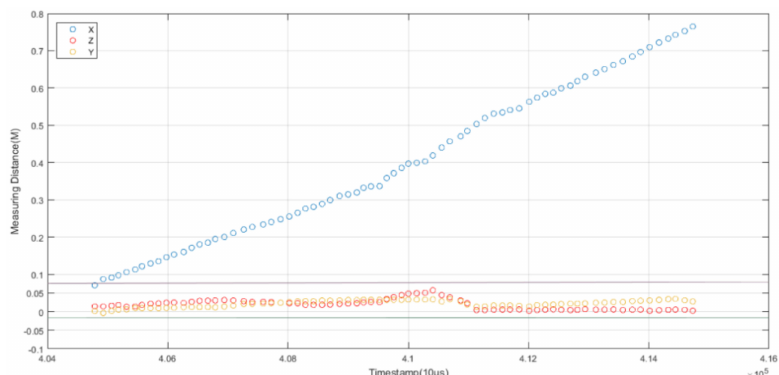
Figure 7. The linear motion experiment.